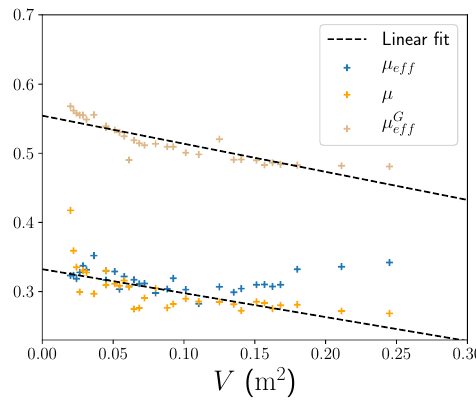
Figure 5. E ↵ ective coe  cient of friction derived from the final runout µ ef f = H / L and from the final position of the = H G / L G , and coe  cient of friction centre of gravity µ G ef f µ = ⌧ / P computed from the stress tensor in the neighbour- hood of the gravity centres.